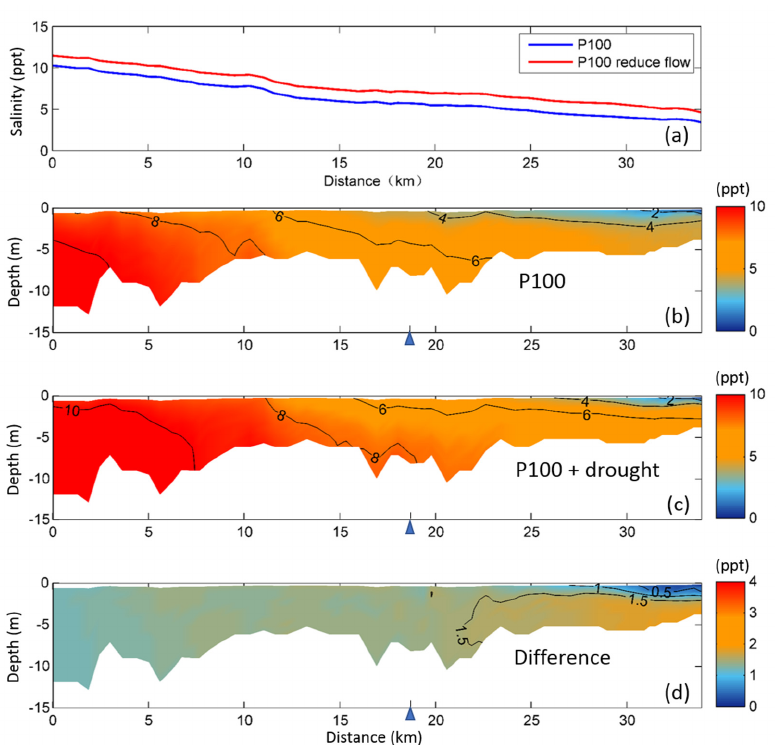
Figure 10. ( a ) Change in the mean salinity distribution with and without flow reduction in the tributary where Xintang is located for 100-cm sea-level rise; salinity vertical profile along the tributary where Xintang is located for ( b ) 100-cm sea-level rise with real flow; ( c ) 100-cm sea-level rise with 30% reduction of flow in winter; and ( d ) the salinity difference between ( c , b ), indicating the change of salinity under extreme conditions. The results are averaged from January 2008. The triangle indicates the location of